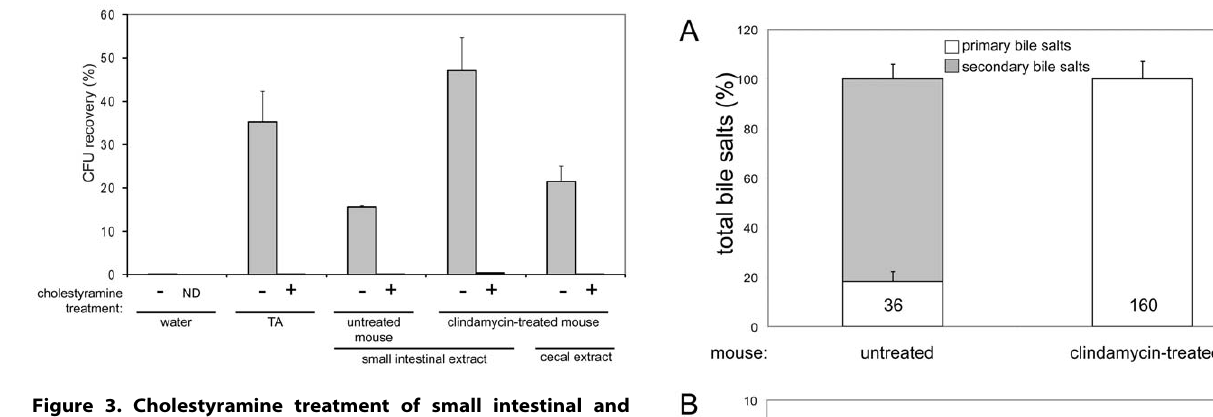
Figure 3. Cholestyramine treatment of small intestinal and cecal homogenates decreases their ability to induce spore germination. CD196 spores were incubated with the indicated germinant for 30 min, then diluted and spread onto BHIS plates. The CFU/ml were compared to the CFU/ml on BHIS plates containing taurocholate (TA), which was considered to reflect 100% germination. Data are the mean of at least three experiments, with error bars representing the standard error of the mean. ND, not done.